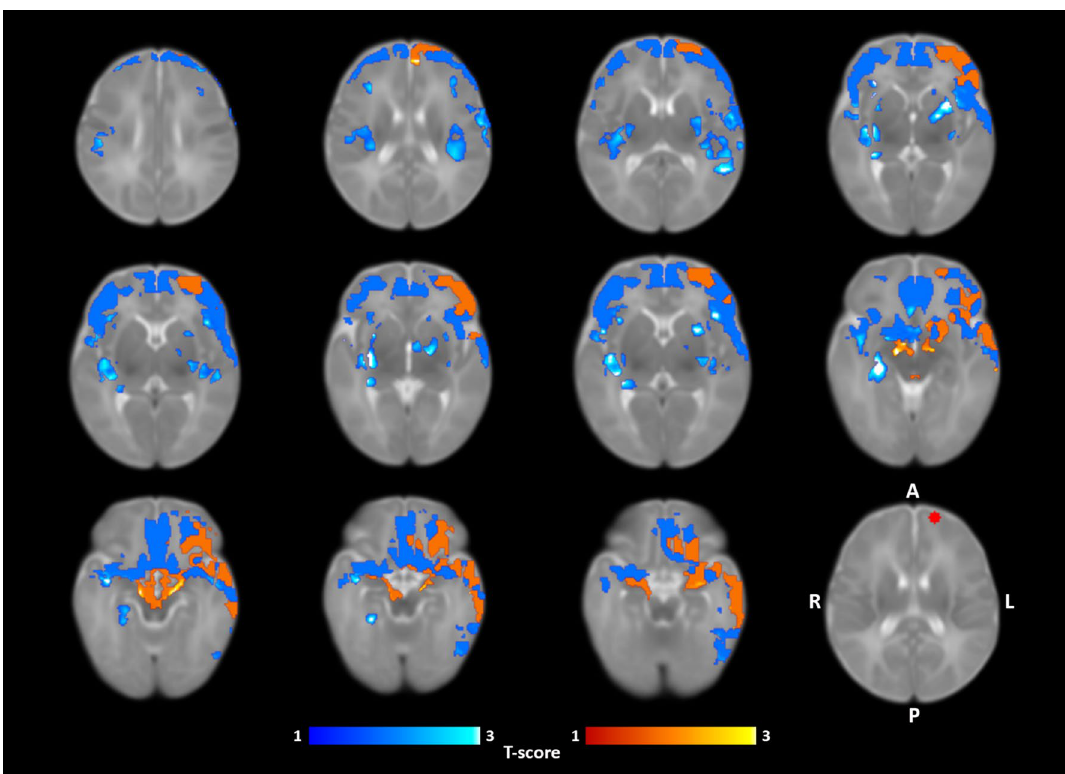
Figure 2. Regions where functional connectivity of the left SFG was positively (orange) and negatively (blue) correlated with maternal pre-pregnancy BMI ( p < 0.05 threshold; p < 0.001 FWE-corrected) in the sleeping neonate (N = 21). Bottom right image displays the left SFG seed ROI in red color (coordinates on the UNC neonate template: X = 79, Y = 157, Z = 86). Color bars represent t-scores. Images are displayed in axial slices on the UNC neonate template. Abbreviations: SFG = Superior frontal gyrus, A = Anterior, P = Posterior, R = Right, L =